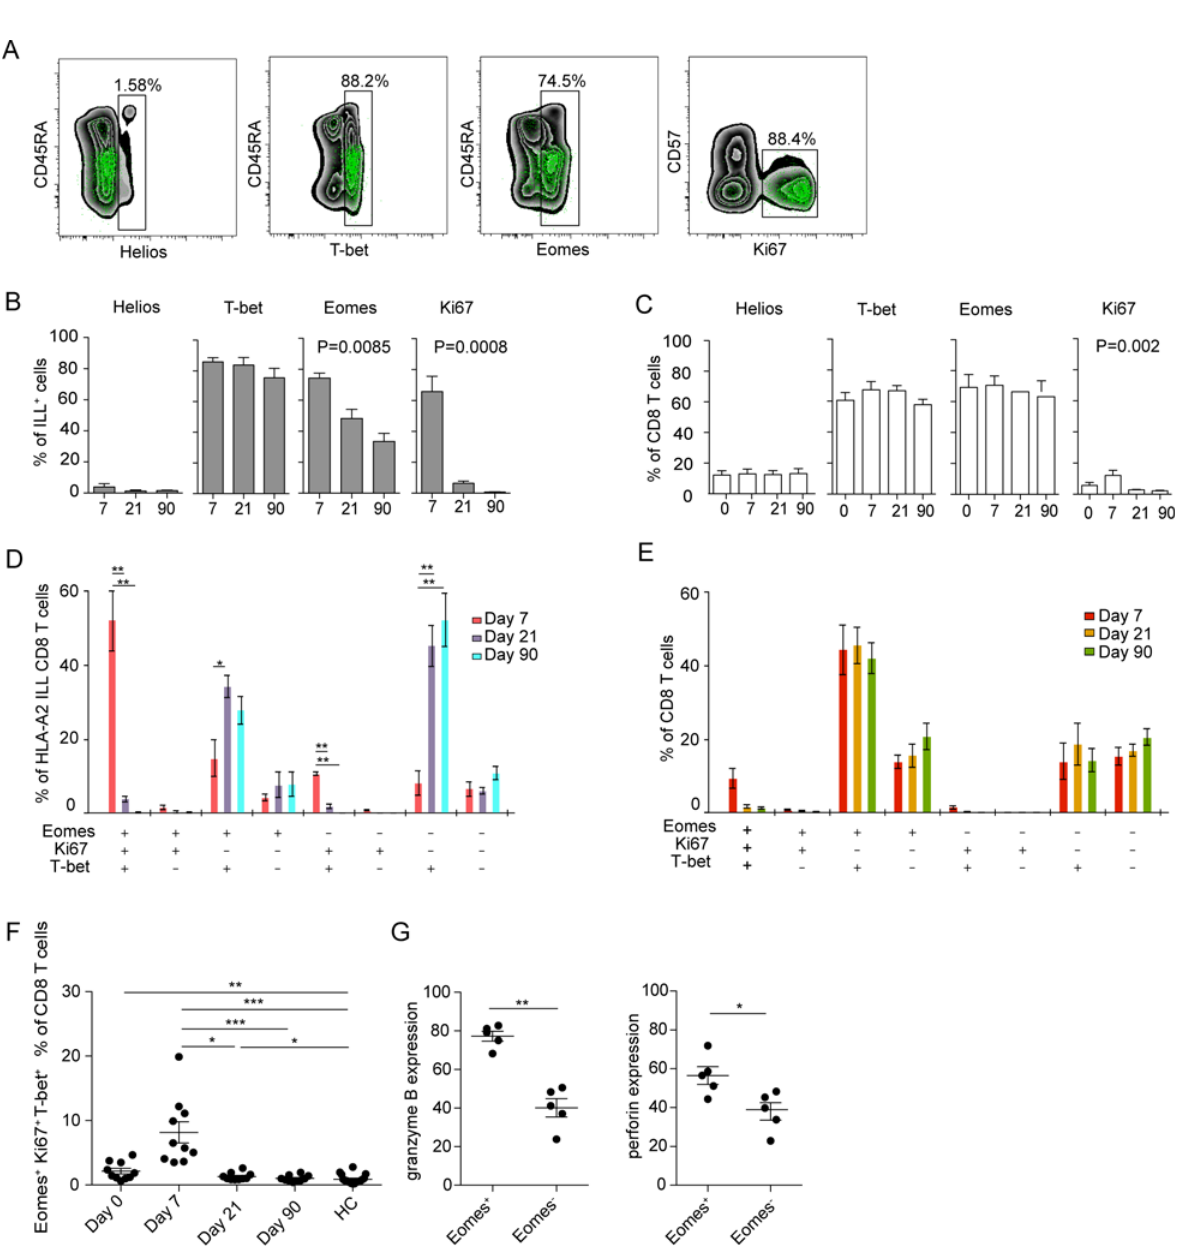
Figure 5. Transcription factor profile of TBEV-specific cells. (A) Plots are gated on total CD8 T cells (black background) or TBEV-specific (NS3 ILL) CD8 T cells (green dots). (B) Bar plots show the median and 10 – 90th percentiles of each marker in ILL + specific cells from five donors. (C) Bar plots show the median and 10 – 90th percentiles of each marker in total CD8 T cells from five donors (D) Bar chart represents subset distribution of T-bet, Eomes and Ki67 in TBEV-ILL-specific cells. (E) Bar chart represents subset distribution of T-bet, Eomes and Ki67 in total CD8 T cells. (F) Median and 10 – 90th percentiles of Eomes + Ki67 + T-bet + total CD8 T cell subset at day 7, 21 or 90 after hospitalization in infected subjects (n = 10) together with healthy controls (n = 16). (G) Median and 10 – 90th percentiles of granzyme B and perforin in Eomes + and Eomes − total CD8 T cell subsets at day 7 after hospitalization. Statistical analysis was performed by using non-parametric repeated measures ANOVA test or Mann-Whitney test. * , p < 0.05; ** , p < 0.01; *** , p <